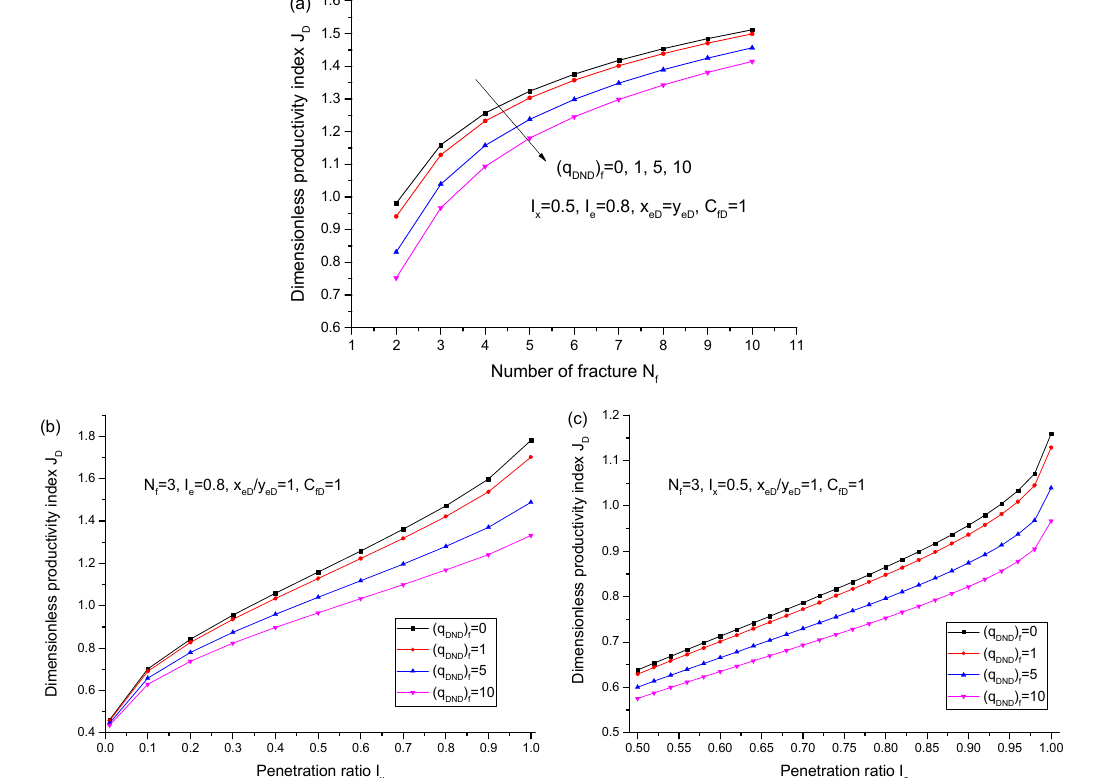
Figure 13. Influence of dimensions of fracture on PI behavior in the consideration of non-Darcy flow, including ( a ) the influence of the number of fractures, ( b ) the influence of penetration ratio of fracture, and ( c ) the influence of penetration ratio of horizontal